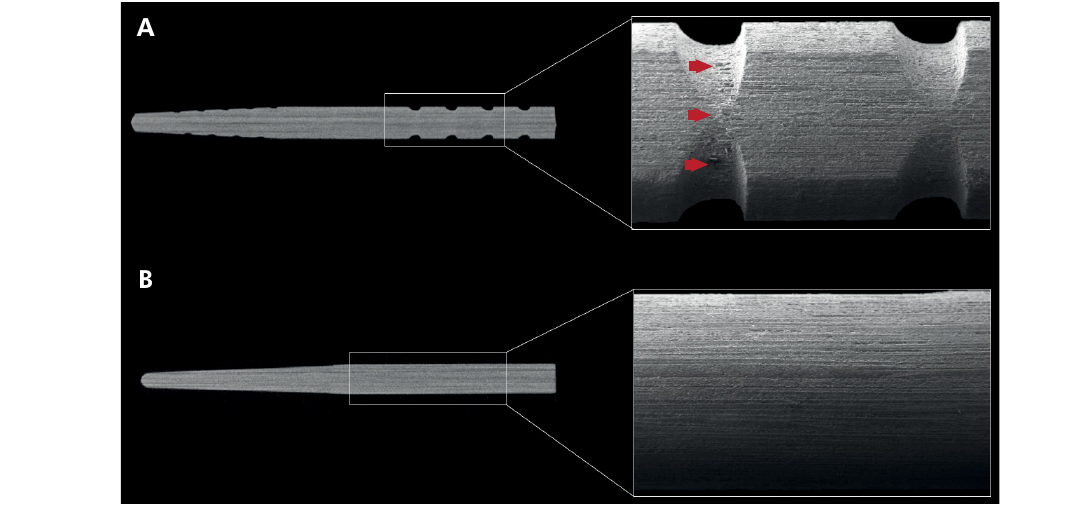
Figure 3. A. Serrated fiberglass post demonstrating the fracture line located caused by cutting of the fibers on the industrially produced post retention; B. Smooth fiberglass post demonstrating perfect integrity of the fibers along the entire